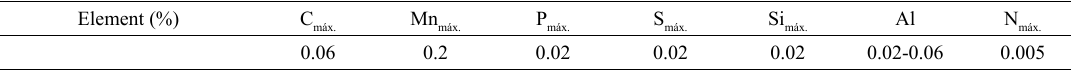
Table 1. Specification obtained by the provider of the steel sheet before receiving the tin electrodeposition. Element (%)